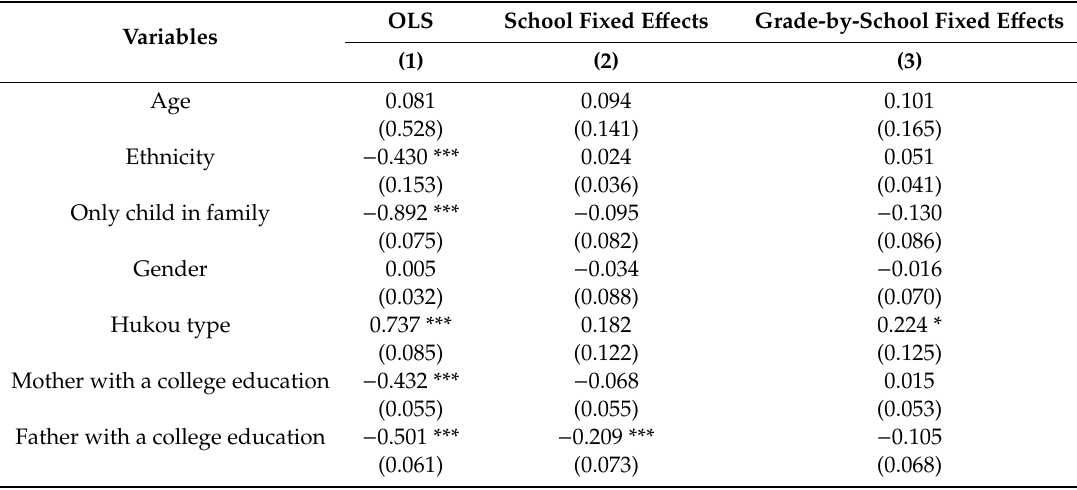
Table 3. Tests for the random assignment